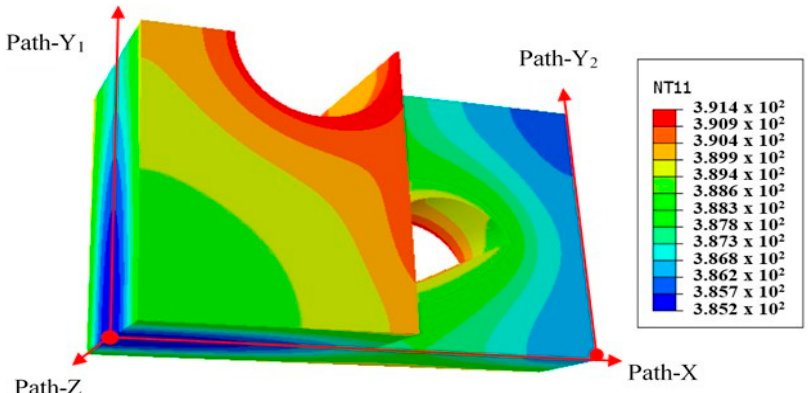
Figure 15. Heat transfer simulation results and path setting. As seen in Figure 15, the highest temperature of the model occurs at the junction between the semi-circular and circular punching holes and the model surface, and the temperature can reach over 390 K, mainly due to the large contact surface between this area and the external environment and the high heat transfer efficiency. This part of the material is prone to deform first in the subsequent stretch process. The lowest temperature of the model occurs at a distance from the punching hole, about 385 K, this part tends to form nodes in the subsequent stretching process. The temperature distributions along path-X, path-Y1, PAth-Y2, and Path-Z paths were statistically analyzed, as shown in Figure 16.